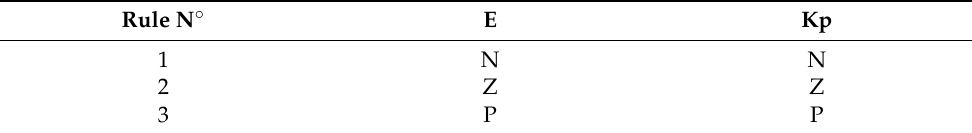
Table 4. Inference rules for Kp.